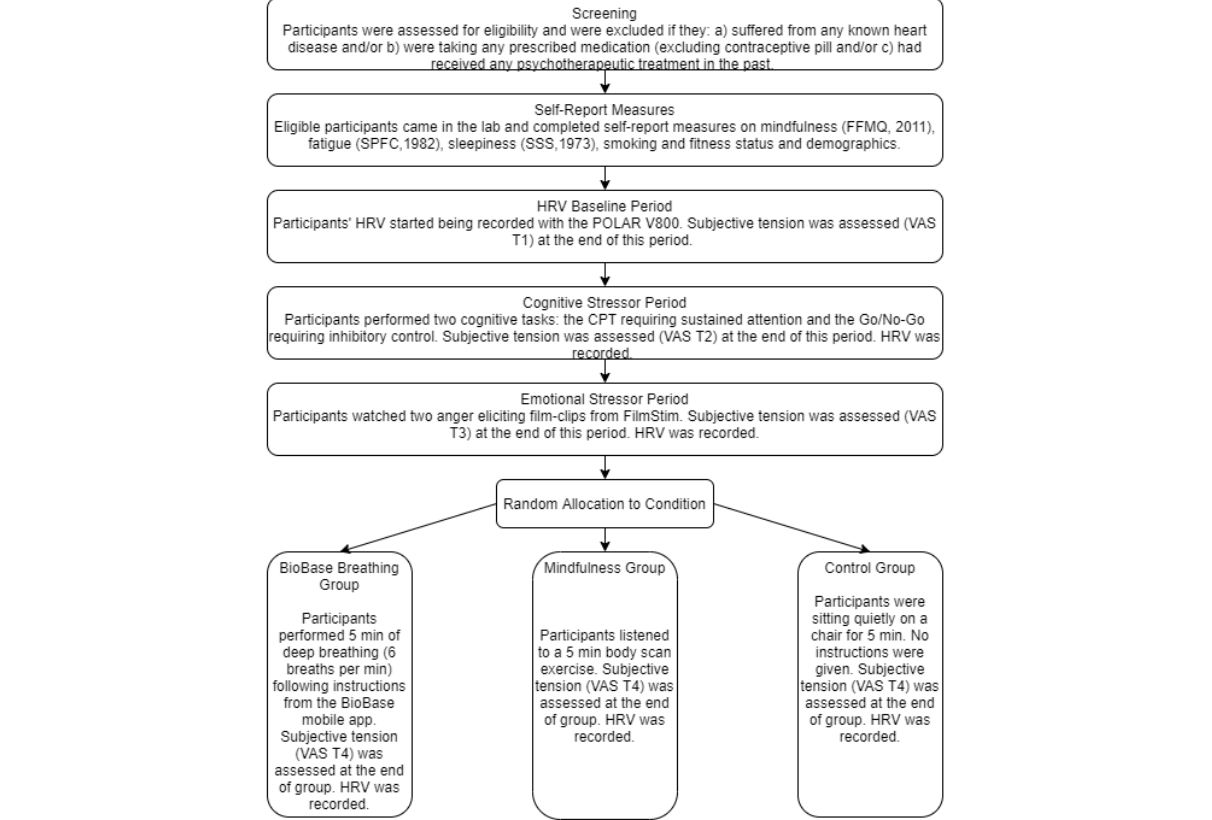
Figure 1. Procedure flow chart. CPT: Continuous Performance Task; FFMQ: Five Factor Mindfulness Questionnaire; HRV: Heart Rate Variability; SPFC: Samn-Perelli Fatigue Checklist; SSS: Stanford Sleepiness Scale; VAS: Visual Analogue